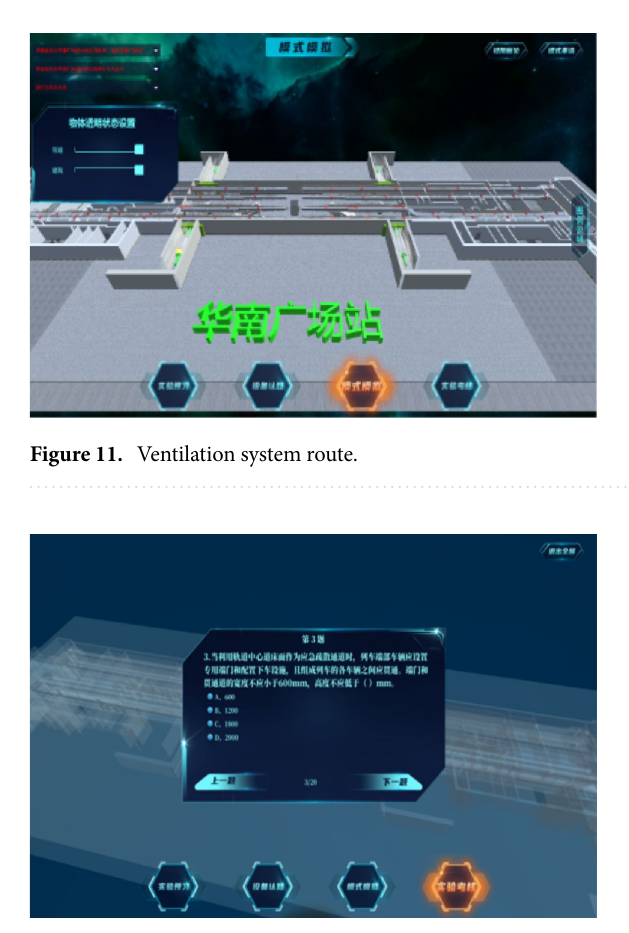
Figure 12. Platform assessment